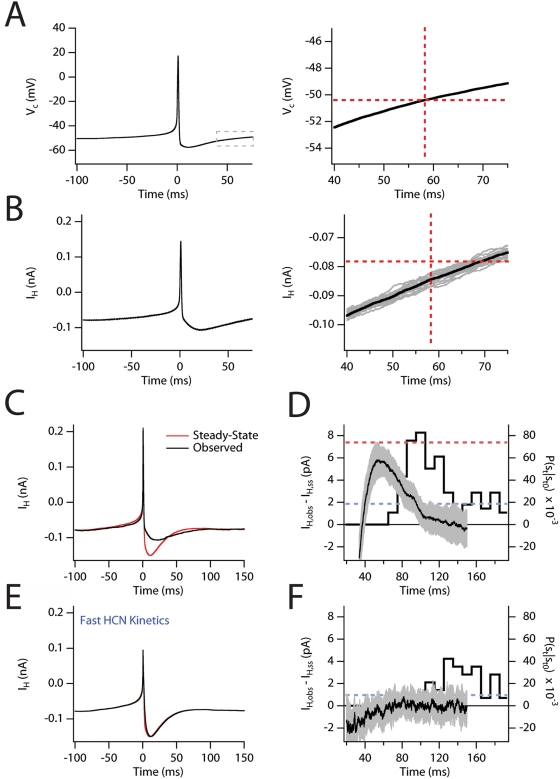
Elevated Ih during AHP recovery correlates with increased
spike probability.(A) The voltage command (Vc) waveform used for voltage-clamp
simulations (left). The voltage command in the region indicated by the
box is also shown on an expanded scale (right). Horizontal line
indicates initial value of the command potential. Vertical line
indicates time at which command returns to its initial value. (B)
Isolated Ih during voltage-clamp of the model to the command
potential in A (average of 10 simulations). (B, right) Isolated
Ih during voltage command return to steady state. The plot
corresponds to the region of the voltage command highlighted in the
right hand panel of A. Solid black line indicates average of 10
simulations shown individually in gray. Vertical and horizontal lines as
in A. (C) Observed Ih (red) is plotted along with the
steady-state Ih density expected at each potential in the
command waveform. (D) Plot of the difference between the observed and
expected steady-state Ih
(Iobs−Iss) during the period of AHP
recovery in the command potential. Superimposed is the plot of the
probability of an action potential, P(st|st0), for
the clustering simulations in Figure 5. Dashed blue line indicates
the average spike probability during the simulation. Red dashed line
indicates the expected spiking probability when the injected current is
increased by 7 pA. Shaded grey area indicates standard error of the mean
of Iobs−Iss. (E) The observed
Ih (red) after increasing the microscopic gating rates is
plotted along with the steady-state Ih density expected at
each potential of the command waveform. (F) Plot of
Iobs−Iss during the period of AHP
recovery in the command potential for the case for the fast
Ih shown in E. Superimposed is the plot of the probability of
an action potential (P(st|st0)) for a clustering
simulation (150 s DC stimulus) with the same injected current as the
data in D.